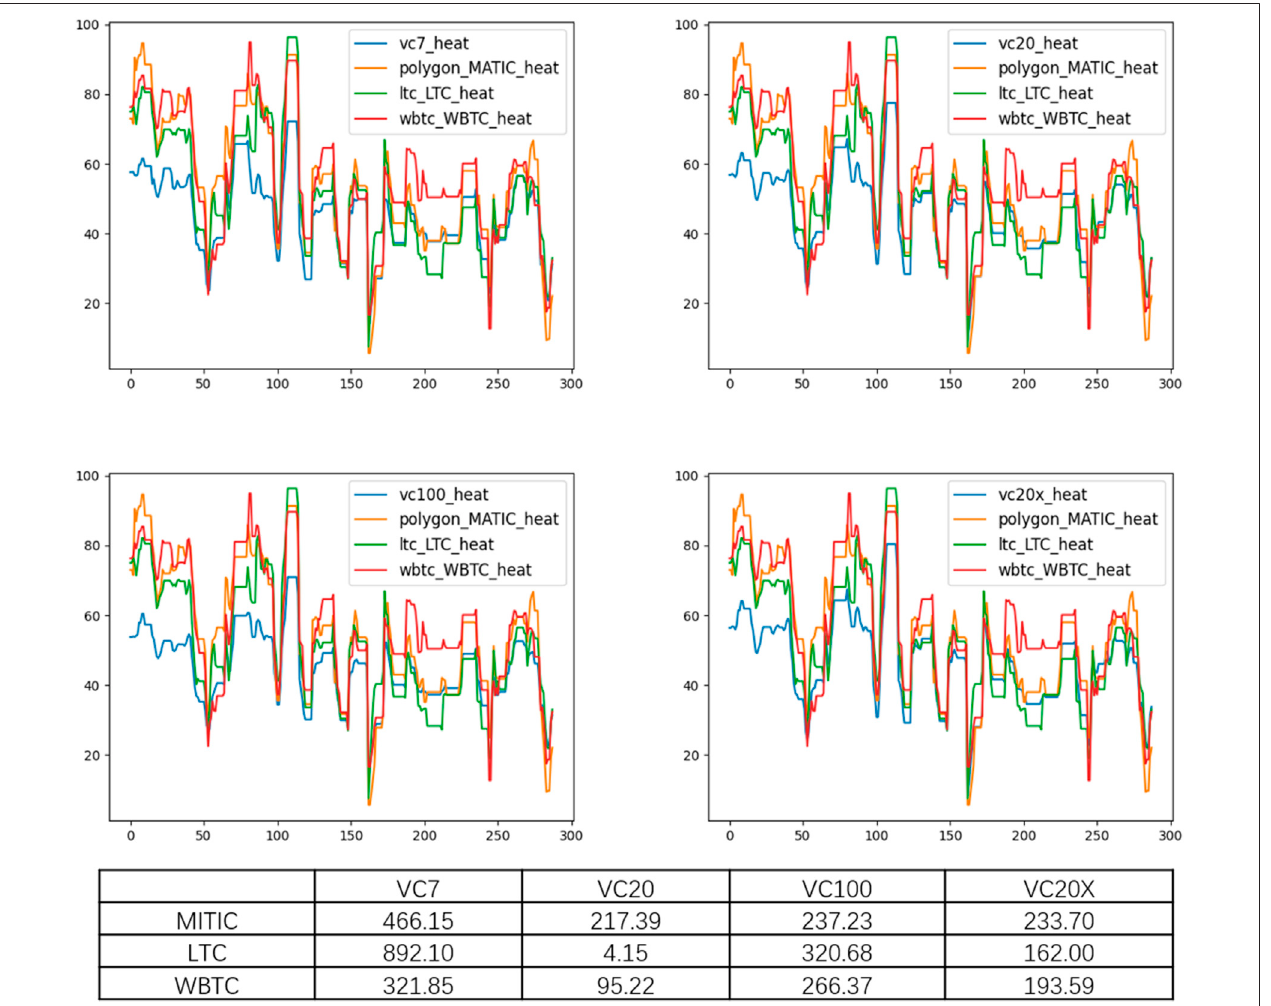
FIGURE 10 | MATIC, LTC, and WBTC popularity values compared with the four indexes on August 3.